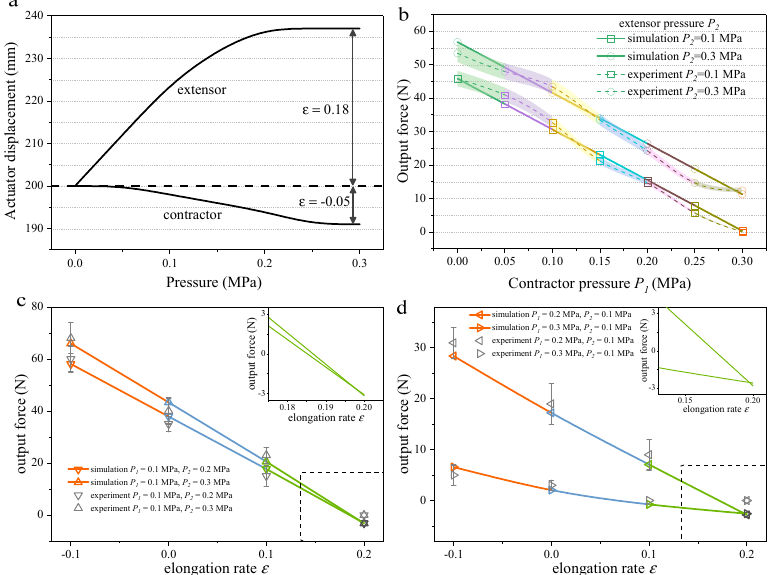
Figure 8. ( a ) The pressure-displacement result of independently pressurizing the extensor or contractor muscles of the actuator separately. ( b ) The pressure-force simulation and experiment results of pressurizing the extensor and contractor muscles of the actuator simultaneously. ( c , d ) When single contractor or extensor pressure is fixed and the other is varying, the elongation rate-output force simulation and experiment results.